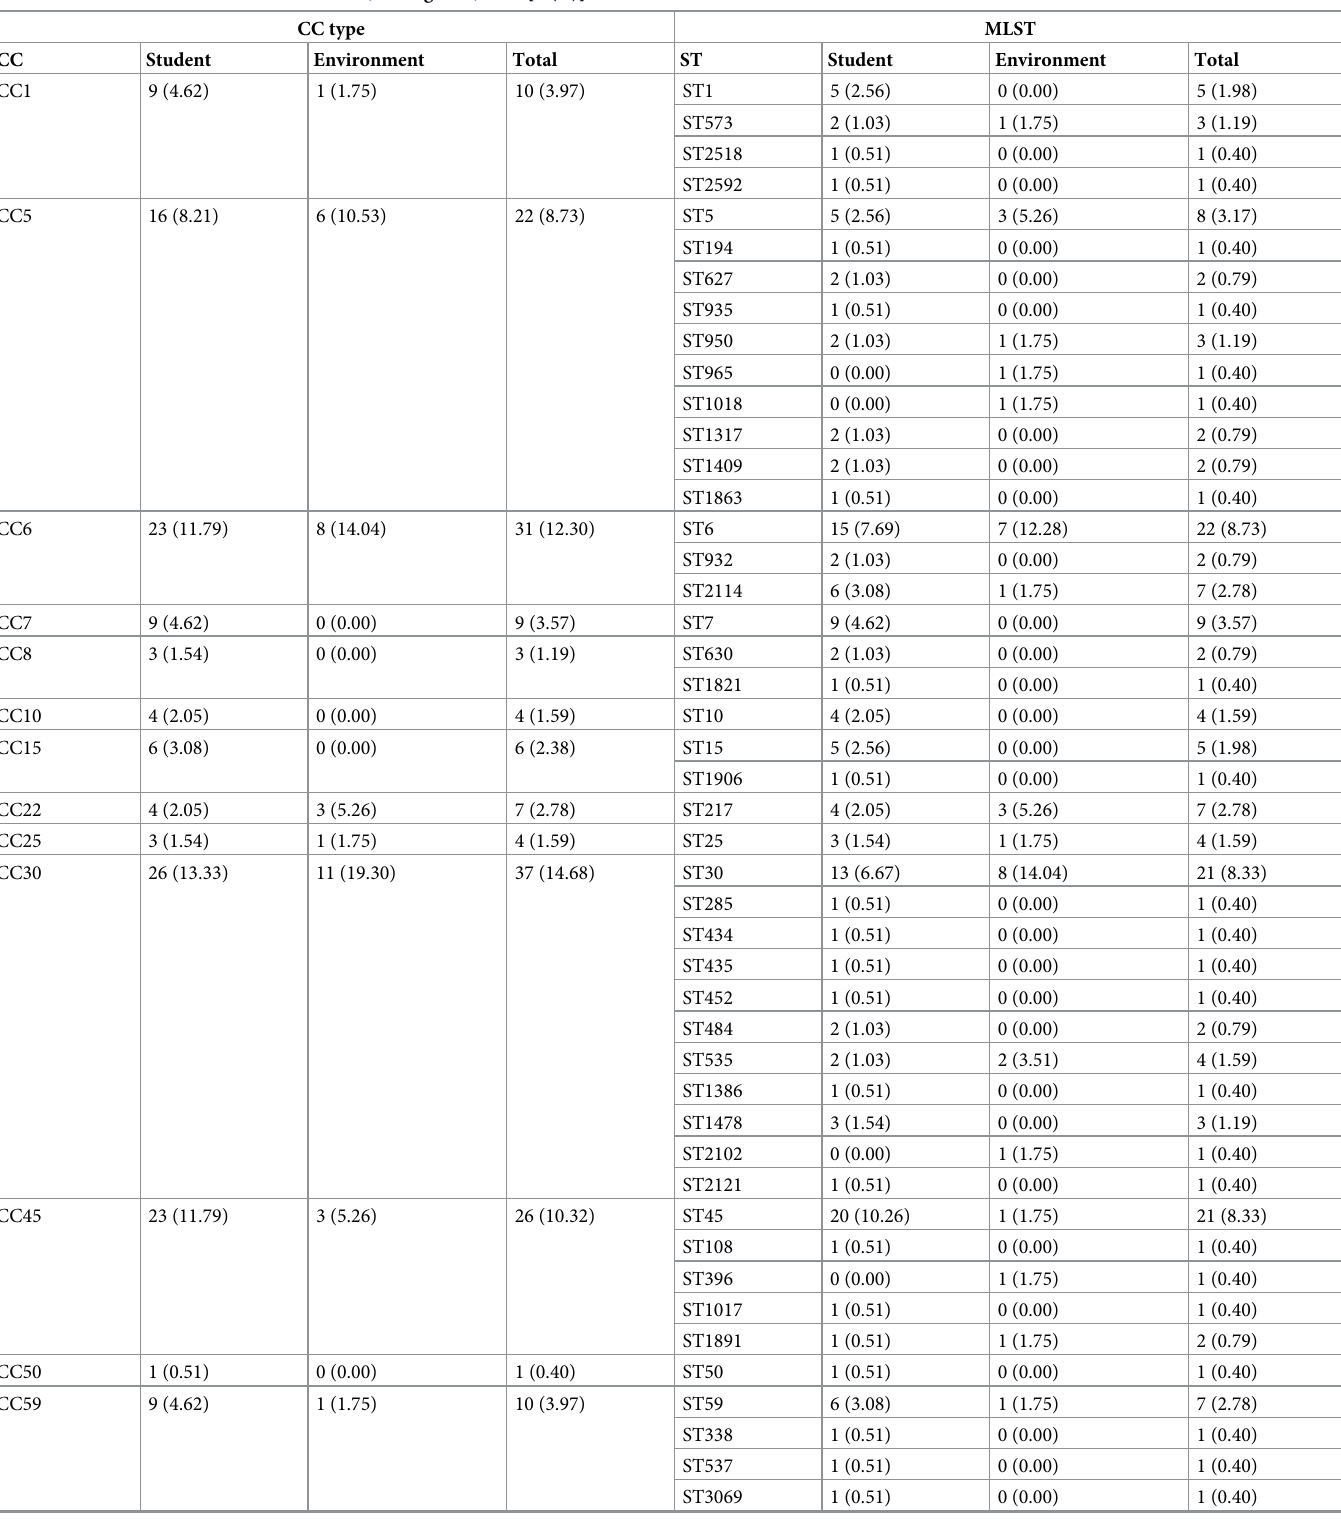
Table 3. MLST distribution of MSSA isolates, Guangzhou, 2016 [n